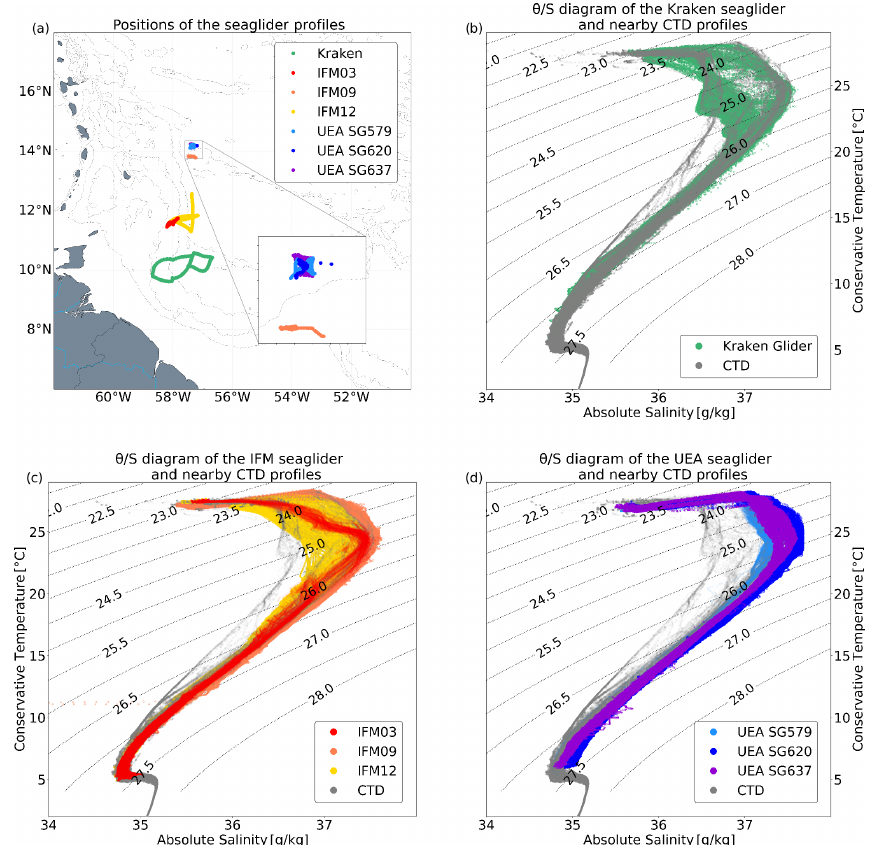
Figure 14. (a) Map of the seven underwater glider positions. (b) θ /S diagram of the Kraken glider measurements, deployed from R/V L’Atalante , compared to nearby CTD casts. (c) Same as panel (b) but for the IFM gliders deployed from R/V Maria S. Merian . (d) Same as panel (b) but for the University of East Anglia gliders deployed from R/V Meteor